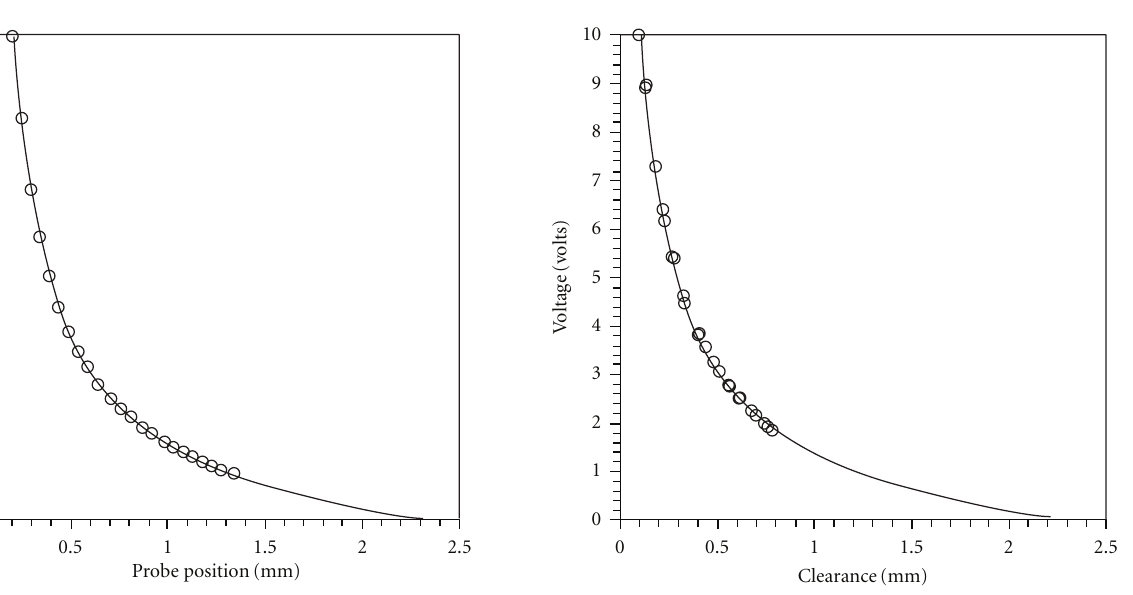
Figure 17: FM capacitance probe output for each blade of the spinning rig wheel plotted against known clearance, over plotted with the recently acquired